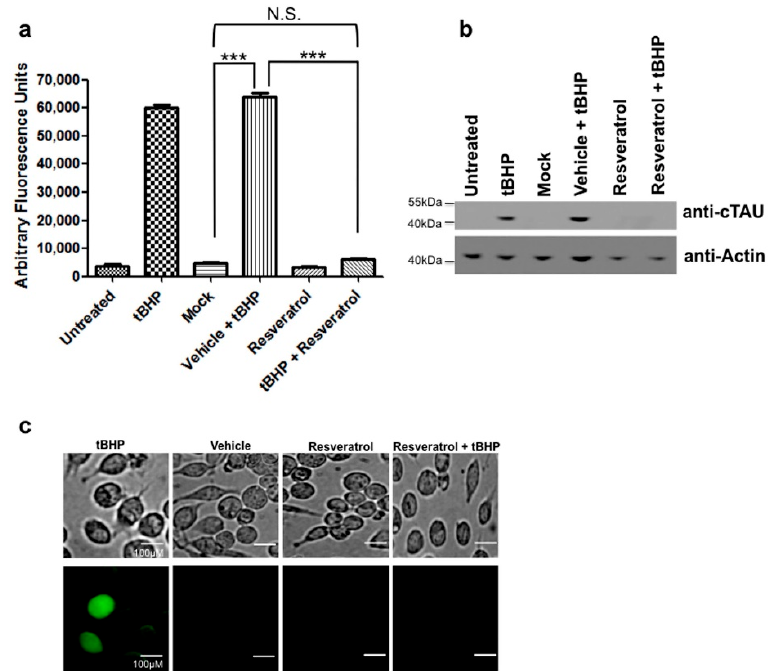
Figure 3. Resveratrol inhibits caspase activation and tau cleavage induced by oxidative stress. ( a ) C6 cells were treated with tBHP to induce oxidative stress and caspase activity measured using the caspase substrate Ac-DEVD-AFC. C6 cells pretreated with resveratrol showed a significant decrease in caspase activity ( p < 0.05). C6 cells that were treated with tBHP showed a significant increase in caspase activity compared to mock treated (***, p < 0.0001). C6 cells treated with tBHP and pretreated